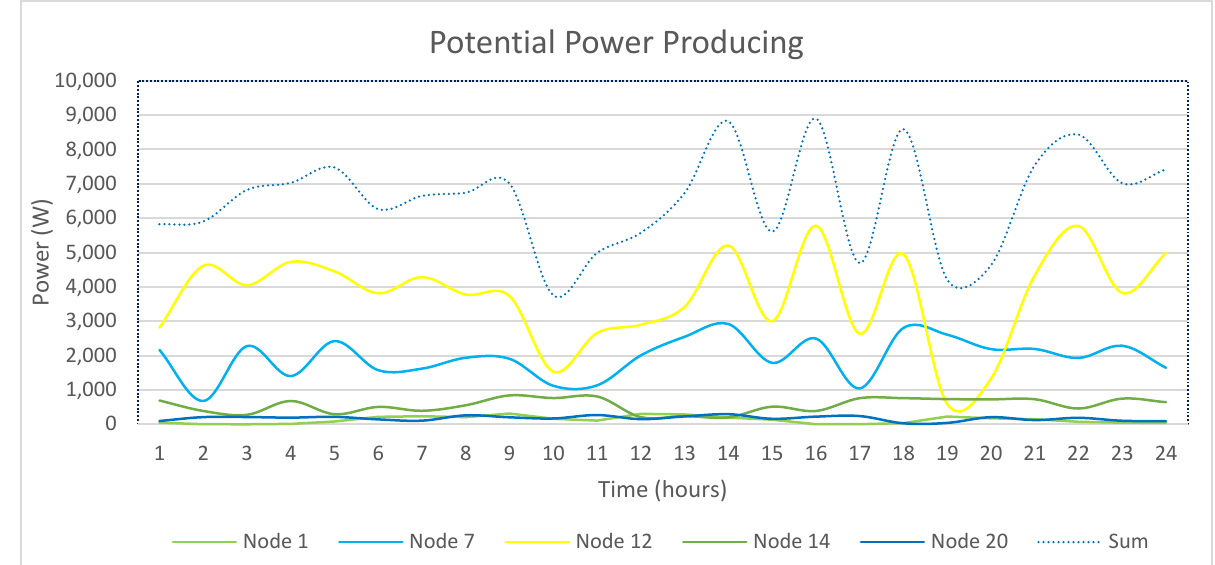
Figure 13. Potential power producing during 24 h.